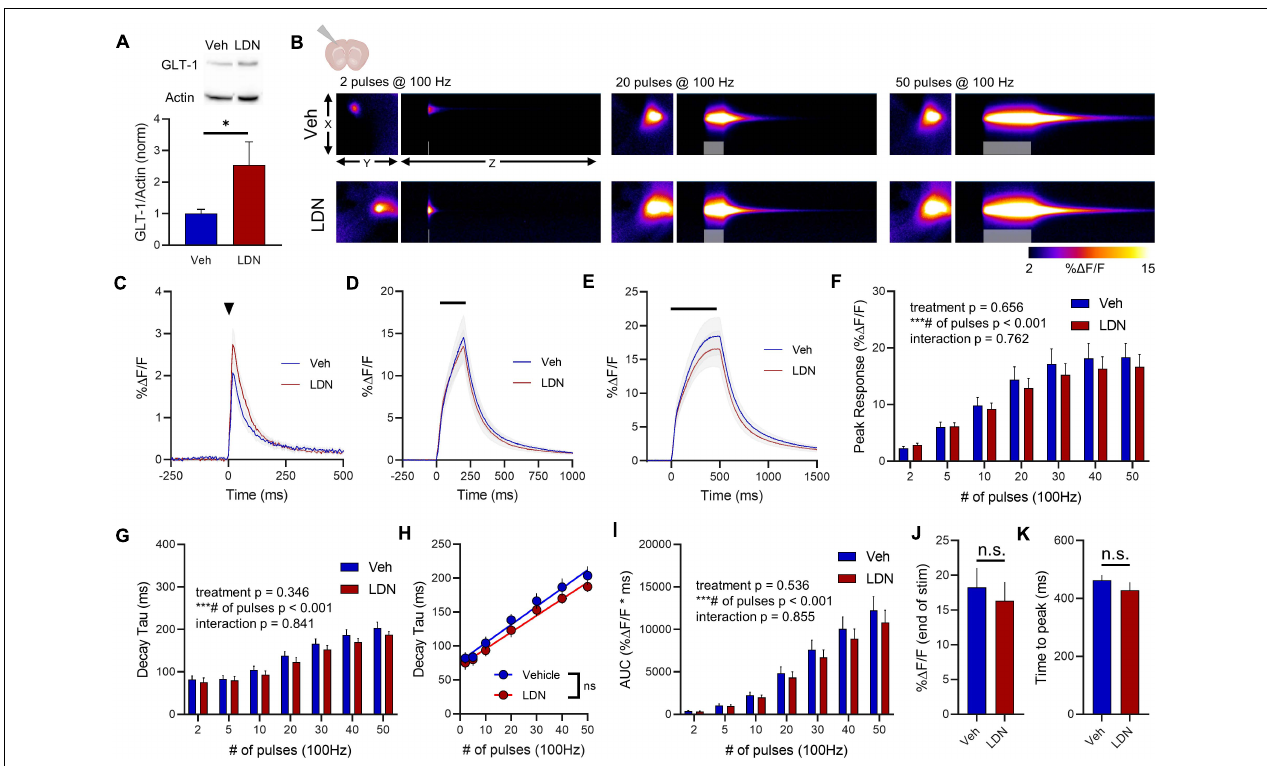
FIGURE 6 | The effect of LDN on glutamate dynamics in the cortex. (A) GLT-1 expression in cortical tissue from vehicle (Veh)- and LDN-treated mice. (B) Representative images depicting the iGluSnFR response evoked by 2 (left), 20 (middle), and 50 (right) pulses of electrical stimulation at 100 Hz in Veh- (top) and LDN-treated (bottom) mice. X–Y images (2048 × 2048 µ m) depict the maximal projection image of the iGluSnFR response while the X–Z image (2048 µ m vertically x 1945 ms horizontally) depicts the iGluSnFR response over time (z-axis). Gray shading indicates the onset and duration of electrical stimulation at 100 Hz. (C–E) Mean ( ± S.E.M in gray) iGluSnFR responses to 2 (C) , 20 (D) , and 50 (E) pulses at 100 Hz in Veh- and LDN-treated mice. Electrical stimulation is denoted by the arrowhead in (C) and the horizontal lines in (D) and (E) . (F) Mean ( ± S.E.M) iGluSnFR response peaks. (G) Mean ( ± S.E.M) iGluSnFR decay tau values. (H) Linear regression to assess the magnitude of the activity-dependent increase in iGluSnFR decay tau. (I) Mean ( ± S.E.M) iGluSnFR area under the curve (AUC). (J) Mean ( ± S.E.M) of the iGluSnFR response size (% (cid:49) F / F ) at the termination of the 50-pulse stimulation paradigm (50 pulses at 100 Hz). (K) Mean ( ± S.E.M) of the time required for the iGluSnFR response to reach a peak during the 50-pulse stimulation paradigm. ∗ p < 0.05, ∗∗∗ p < 0.001. n.s. not significant. Brain slice schematic in (B) was created using